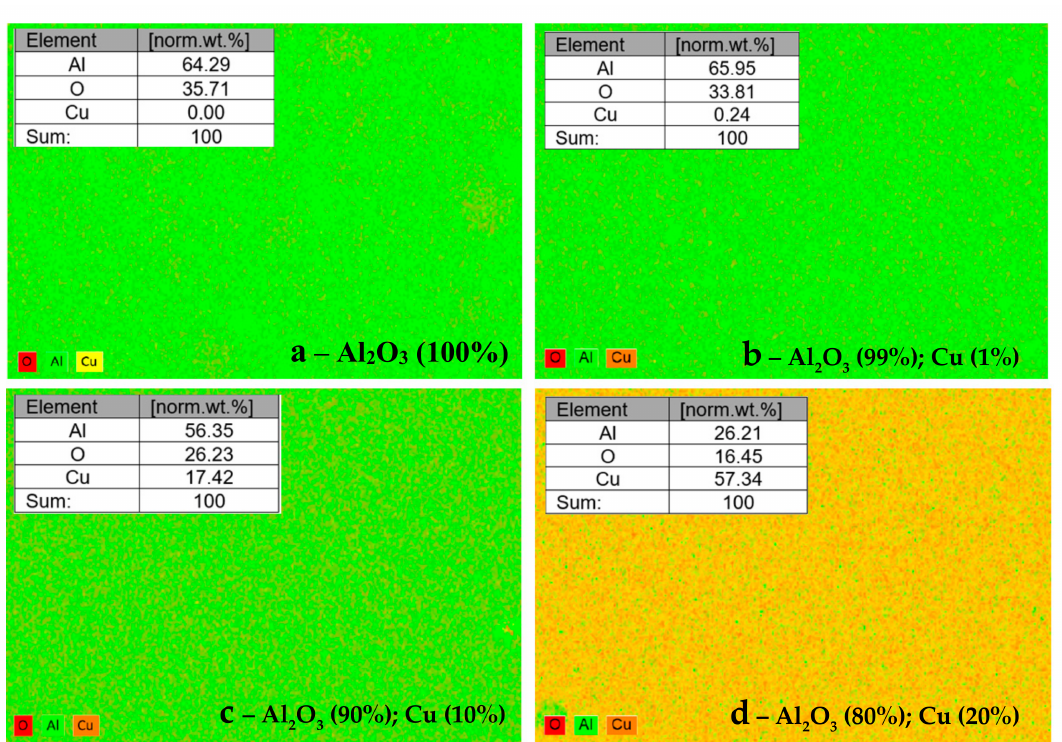
Figure 6. Surface distribution of the coating